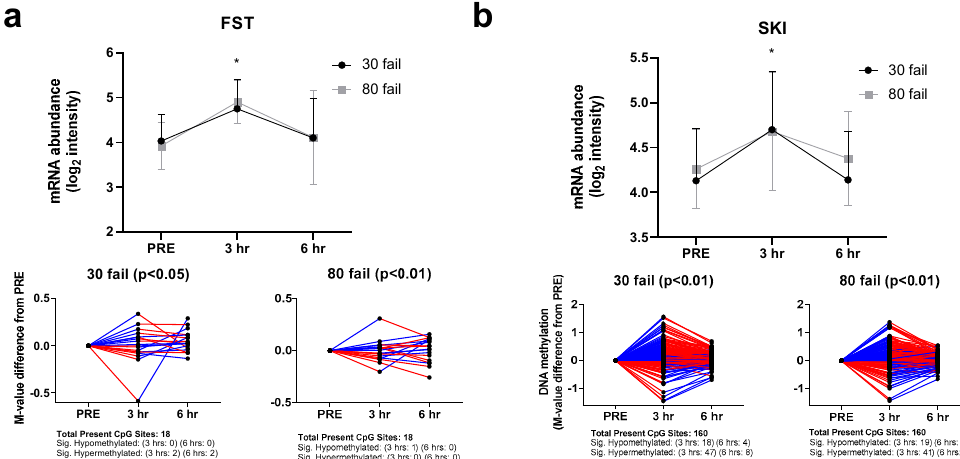
Figure 3. FST and SKI mRNA and DNA methylation responses. mRNA and methylation responses of follistatin (FST, panel ( a )) and SKI Proto-Oncogene (SKI, panel ( b )), both of which are inhibitors of myostatin signaling. Notably, resistance exercise (regardless of load) upregulated these mRNAs, and neither mRNA response was seemingly associated with CpG site methylation patterns. Symbol: *, indicates mRNA at 3 h or 6 h post-exercise was significantly downregulated. Other note: CpG sites are depicted as M-value changes from PRE, where red coloration indicates a directional change downward, and blue indicates a directional change upward.